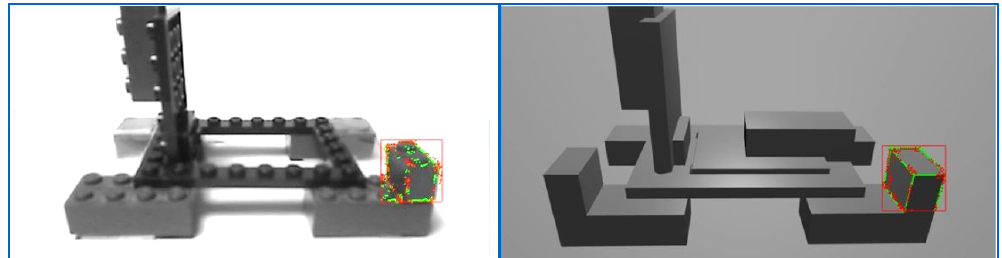
Figure 14. Successful validation phase: comparison between real object (on the left) and virtual model (on the right).